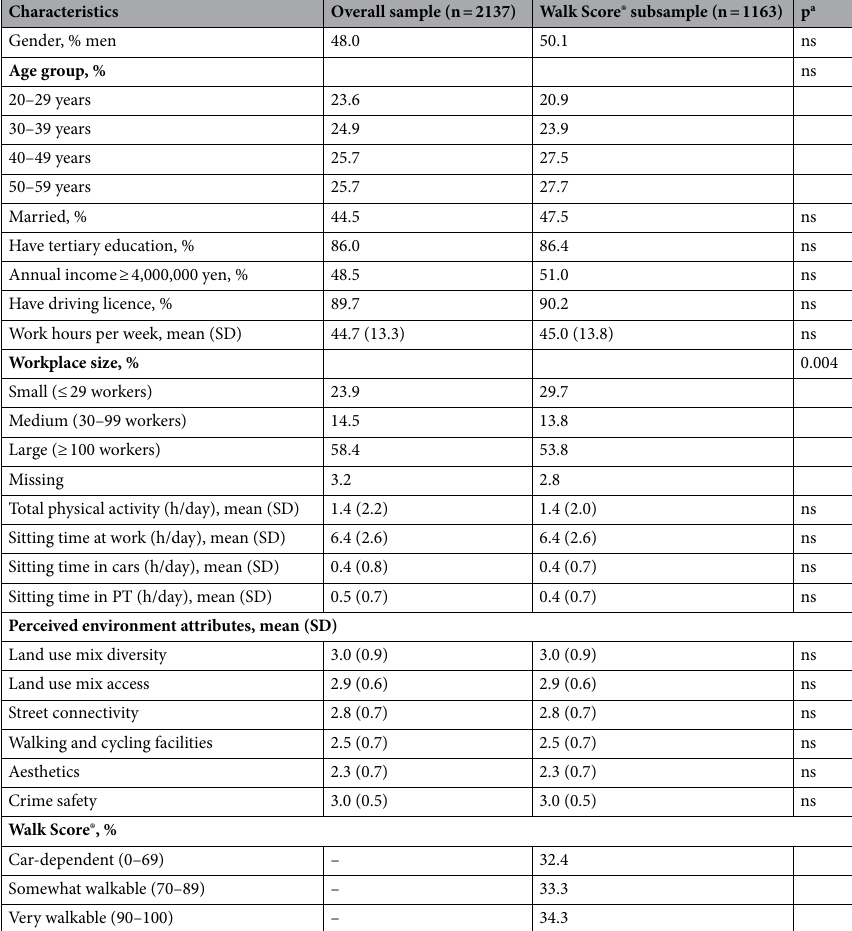
Table 1. Characteristics of participants and workplace neighbourhood environments. SD standard deviation, ns non-significant, PT public transport. a Difference across subsample categories was tested using x 2 for categorical variables and t-tests for continuous variables.